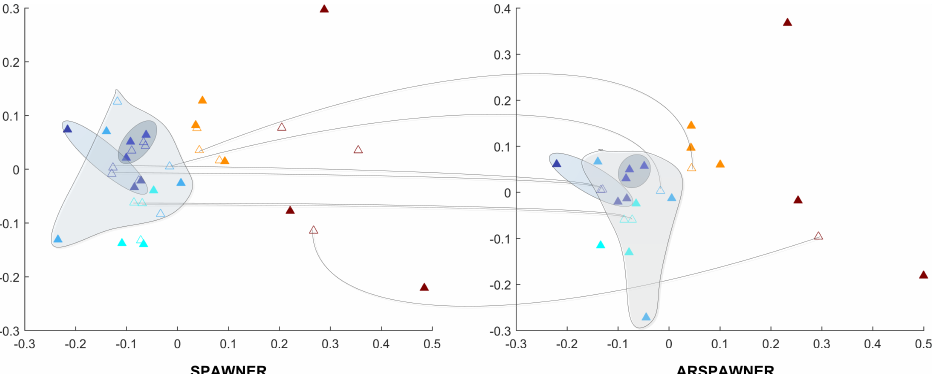
Figure 1. Class boundaries in the 2D MDS embeddings of DTW dissimilarities for the exemplary time series from the MSRA I dataset generated by SPAWNER and ARSPAWNER. Boundaries of neighboring classes are